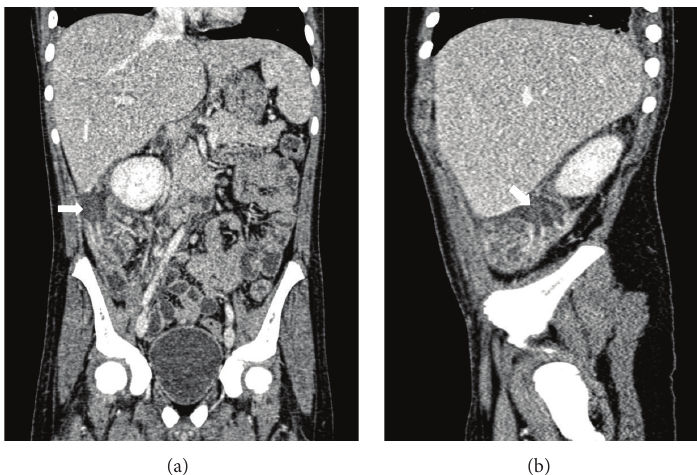
Figure 2: Contrast enhanced CT with coronal (a) and sagittal (b) images showing ruptured (arrow) appendix at the distal body with localized periappendicular